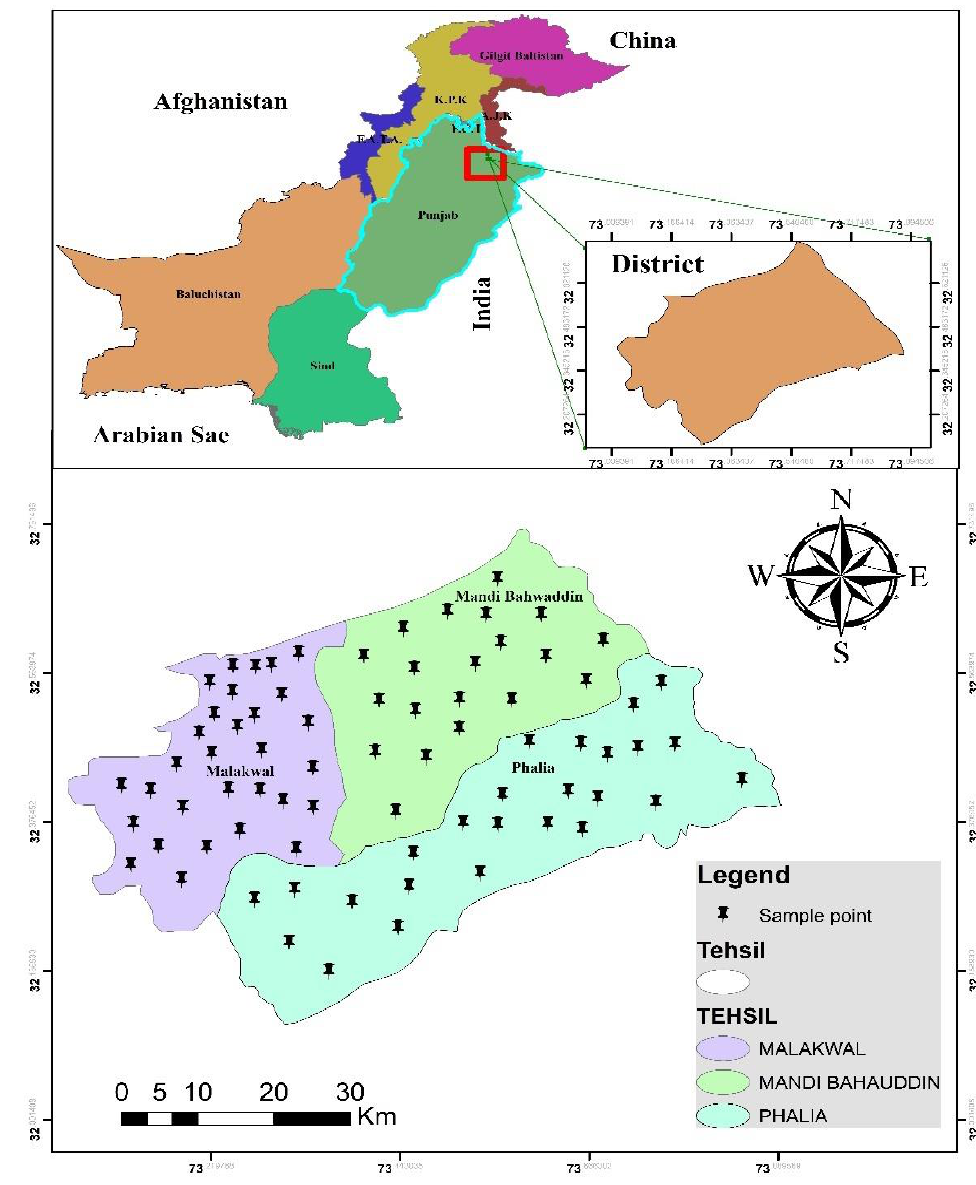
Figure 1. Map of the study area and sampling points.